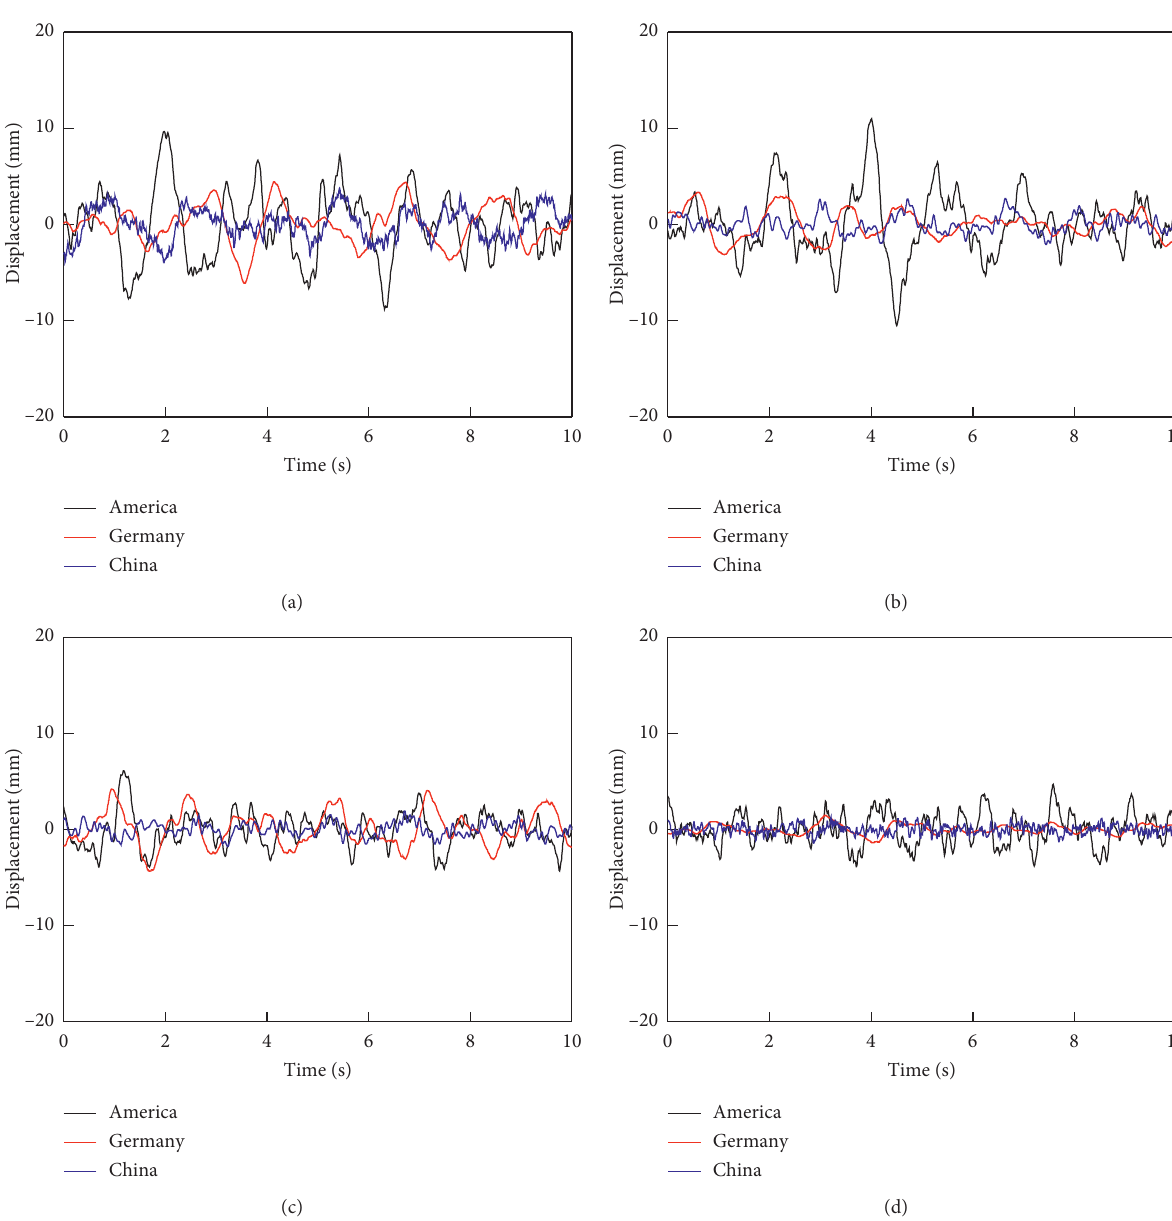
Figure 4: The comparison of the time-domain sample for (a) vertical, (b) alignment, (c) cross, and (d) gauge rail